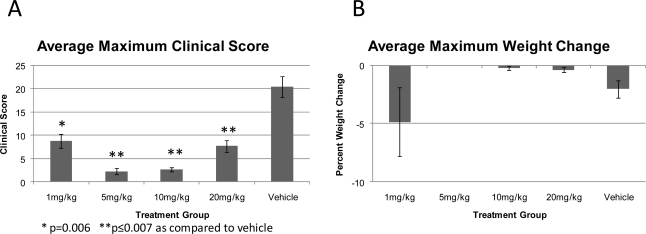
Disease severity measurements for evaluation of minimum dosage of CMX001 to provide protection from RPV disease. Animals were dosed at concentrations and schedules as outlined in Table 1. (A) Average maximum clinical scores for each animal per group over the course of the experiment. (B) Average maximum percent weight loss from weight at day 0 for each animal per group over the course of the experiment.